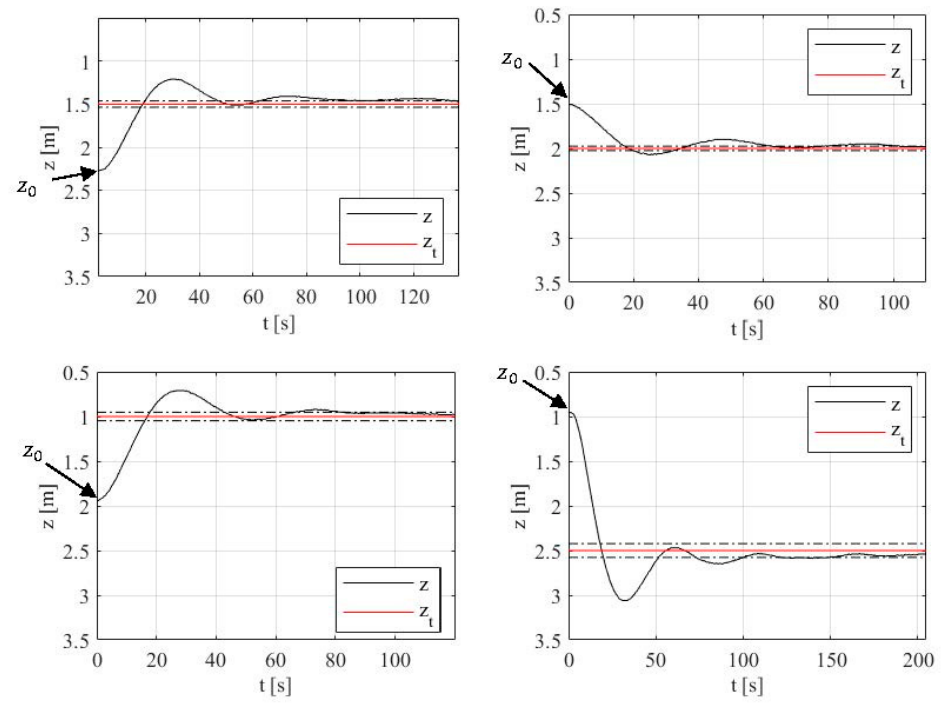
Figure 13. PID depth controller experimental results: z is the BCD depth, z t is the target depth and the dashed dot lines represent a ± 5% band around z t.